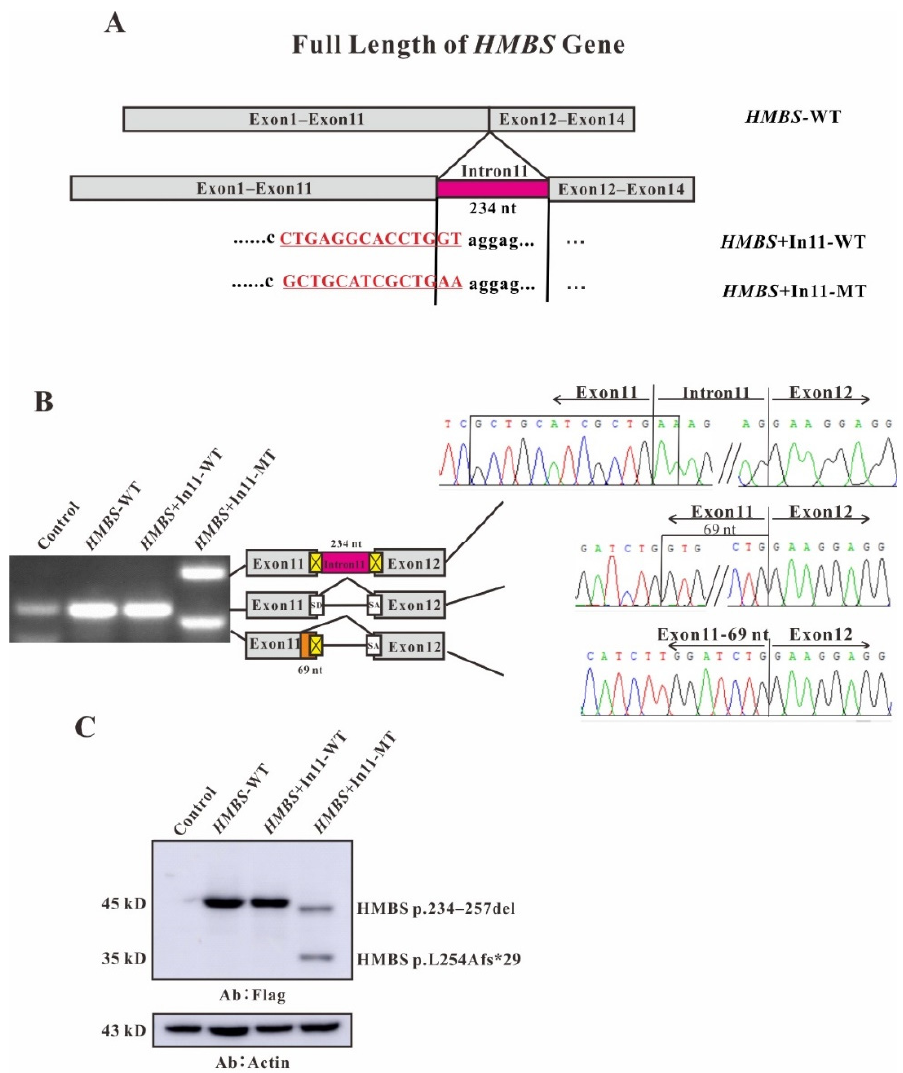
Figure 2. Full length with intron 11 of HMBS gene constructs for splicing pattern investigation. ( A ) Schematic representation of the HMBS gene with intron 11 construct. The nucleotide sequences of the HMBS +In11-WT and HMBS +In11-MT are shown below. The changed nucleotide in exon 11 and intro 11 of both wildtype and mutant HMBS full gene are labeled by red and underscore. ( B ) Gene splicing assay. HMBS -WT, HMBS +In11-WT and HMBS +In11-MT were transiently transfected into HEK293T cells. After RNA isolation the splicing products were analyzed by RT-PCR. The middle bands represent correct splicing, whereas the higher band represents the HMBS inserted 234 nt, the full length of intron 11 and the lower bands represent the HMBS missing 69 nt in exon 11. ( C ) Western blot analysis for the expression of HMBS -WT, HMBS +In11-WT and HMBS +In11-MT. Whole cell lysates were separated by SDS-PAGE (12% acrylamide). Flag monoclonal antibodies were used.